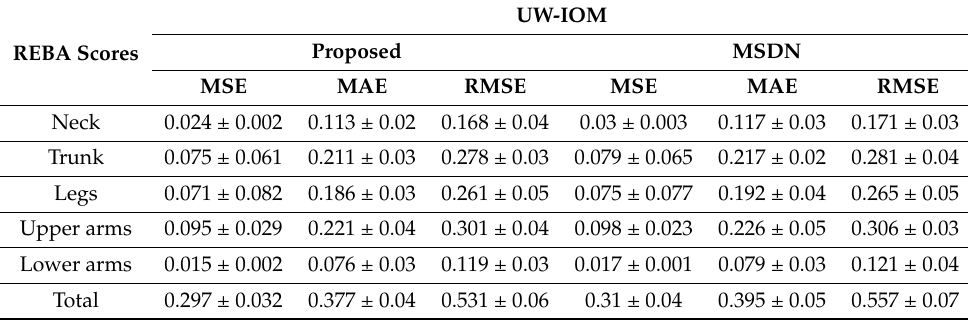
Table 4. Performance of the proposed method in terms of partial and total REBA scores in the UW-IOM